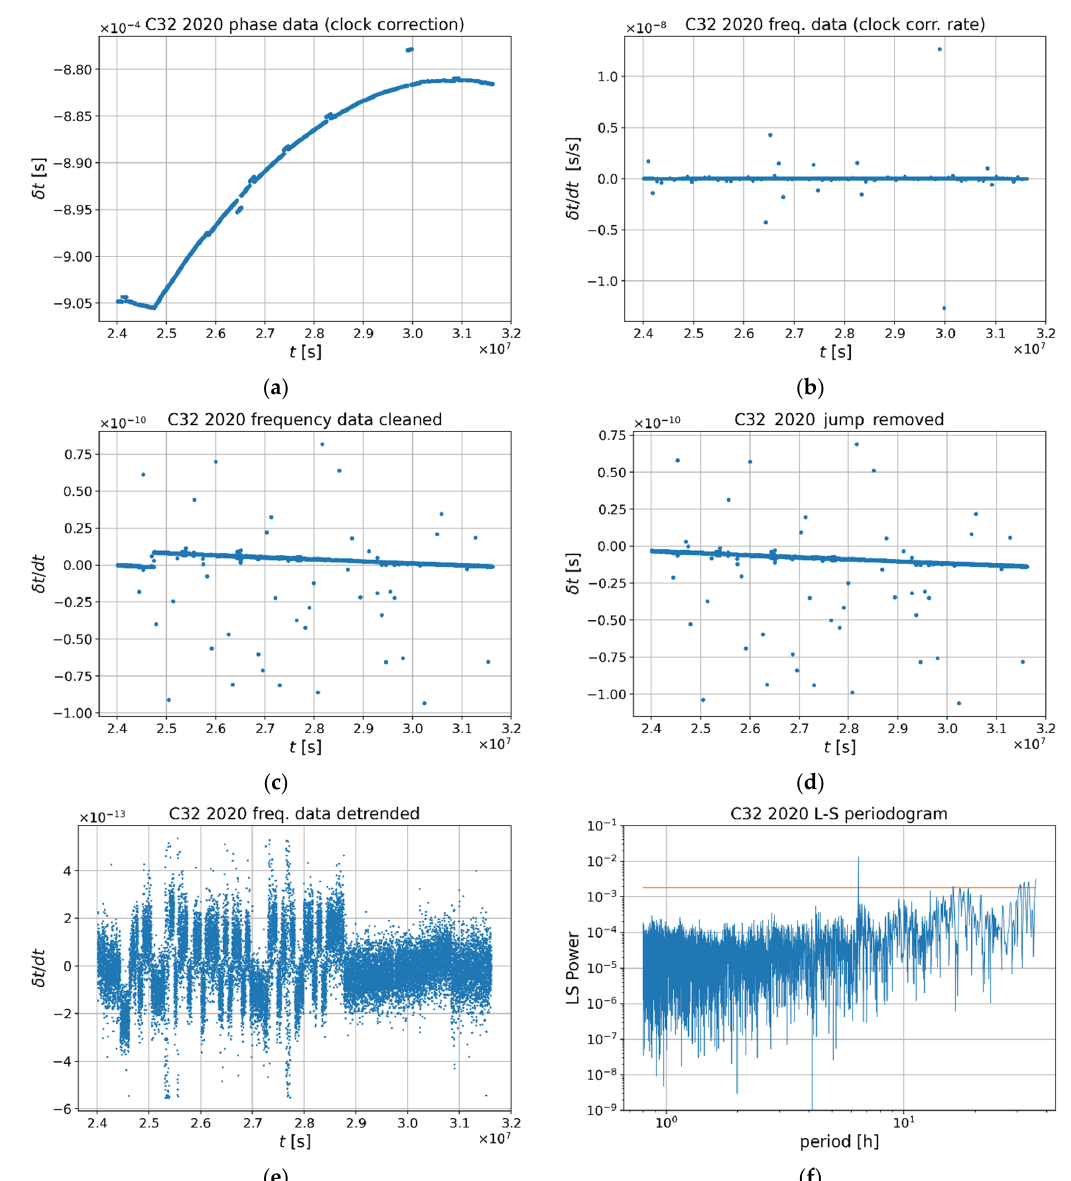
Figure 3. Stages of data processing. ( a ) Original clock correction data (phase data). ( b ) Clock correction rate (frequency data). ( c ) Clock correction rate after elimination of outliers larger than 10 − 10 s. ( d ) Clock correction rate values after removal of the detected jump. ( e ) Clock correction rate after removal of the trend and outliers with the MAD method. ( f ) Lomb-Scargle periodogram.